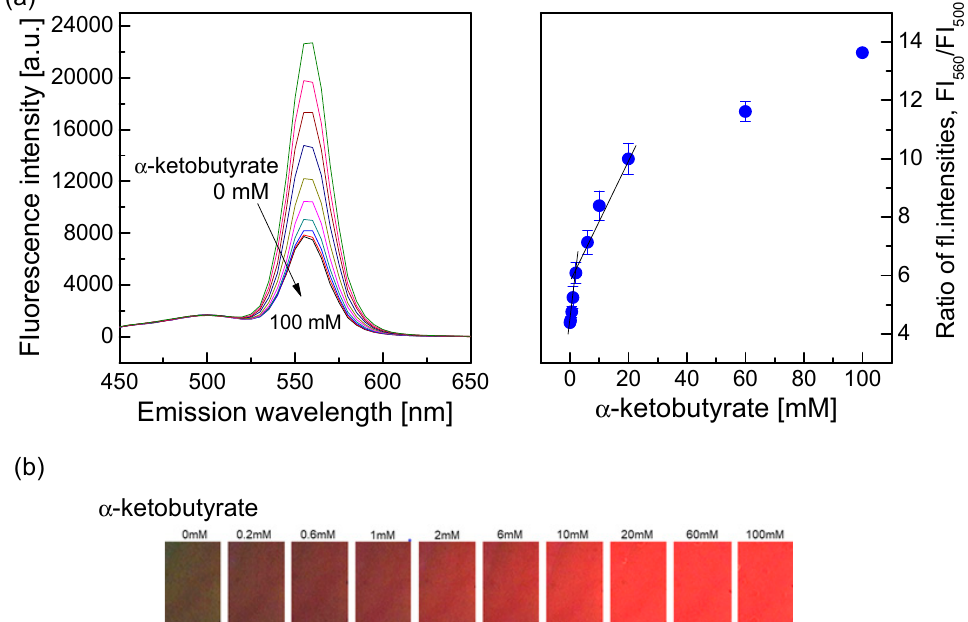
Figure 11. ( a ) Fluorescence emission spectra of the QD–AF membrane at different concentrations of α -ketobutyrate and a fixed concentration of H 2 O 2 (10 mM) with calibration curve of α -ketobutyrate determined by the FI 560 /FI 500 . ( b ) Color images of the fluorescence quenching of the QD–AF membrane exposed to the residual H 2 O 2 from the reaction with different concentrations of α -ketobutyrate.